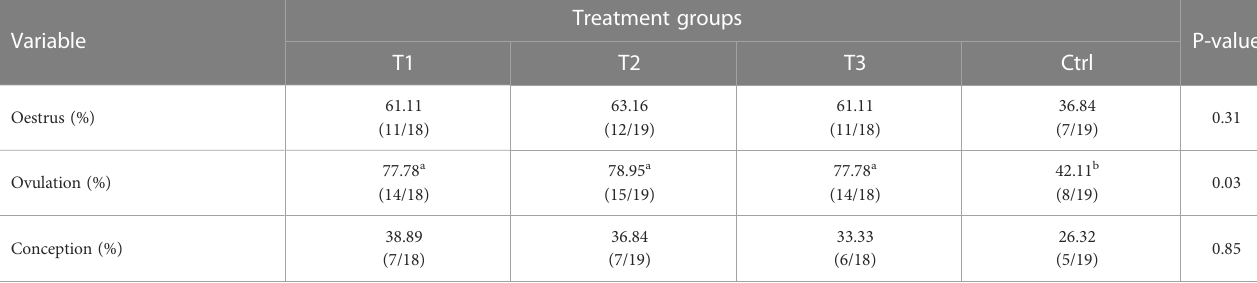
TABLE 4 Rates of oestrus, ovulation, and conception between different groups.